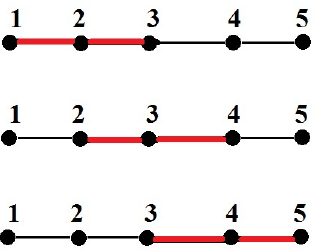
Figure 6. There are three possible packings of L 5 by triples. According to Lemma 8, x 1 = x 2 = x 4 = x 5 = 0. Moreover, x 1 + x 2 + x 3 = 1, so x 3 = 1. There is only unique point in the core: ( 0;0;1;0;0 ) .